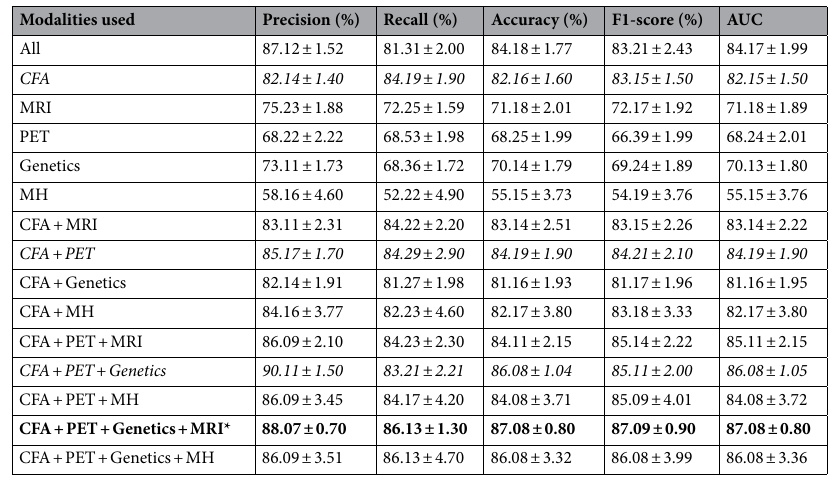
Table 4. Random Forest performance validation for predicting whether MCI subjects will progress to AD or not ( tenfold cross-validation ; Second Layer). BA: Balanced accuracy. Asterisk ( *): is the subset of features with the best predictive performance. Performance: Mean ± standard deviation.